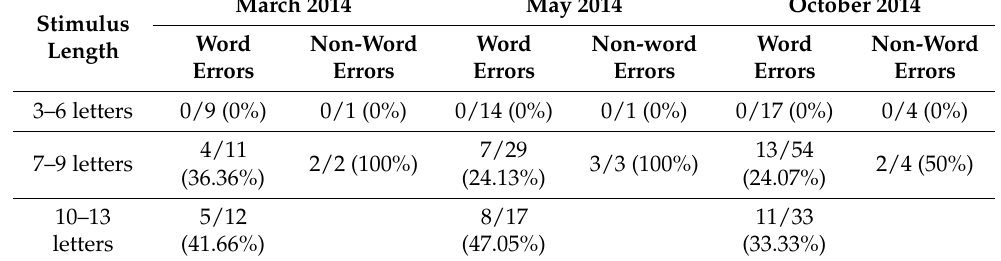
Table 3. Number of stimuli transcription errors and percentages under dictation in the function of stimulus length during the assessments in March, May, and October 2014.